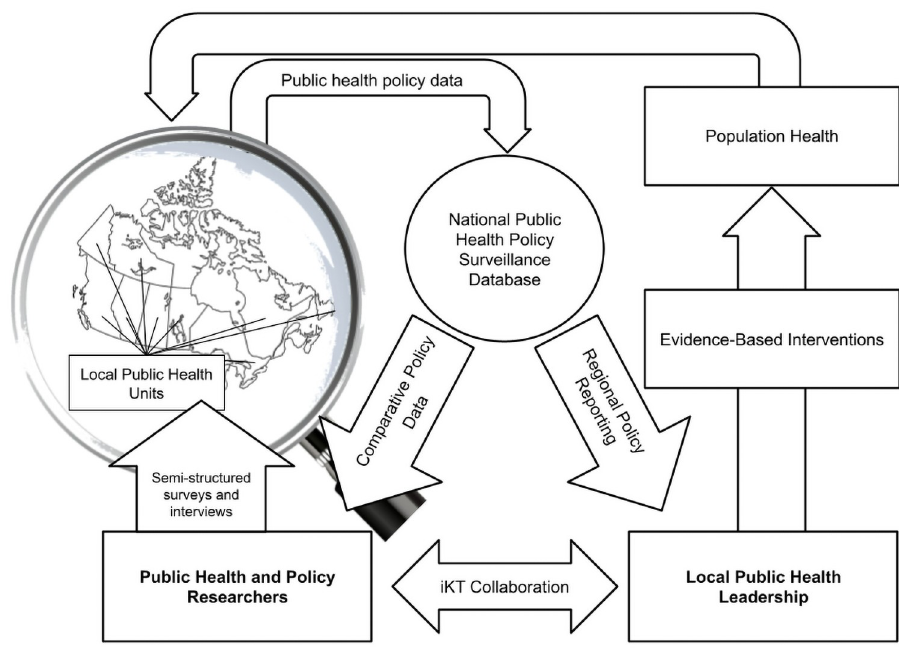
Fig 3. Policy surveillance